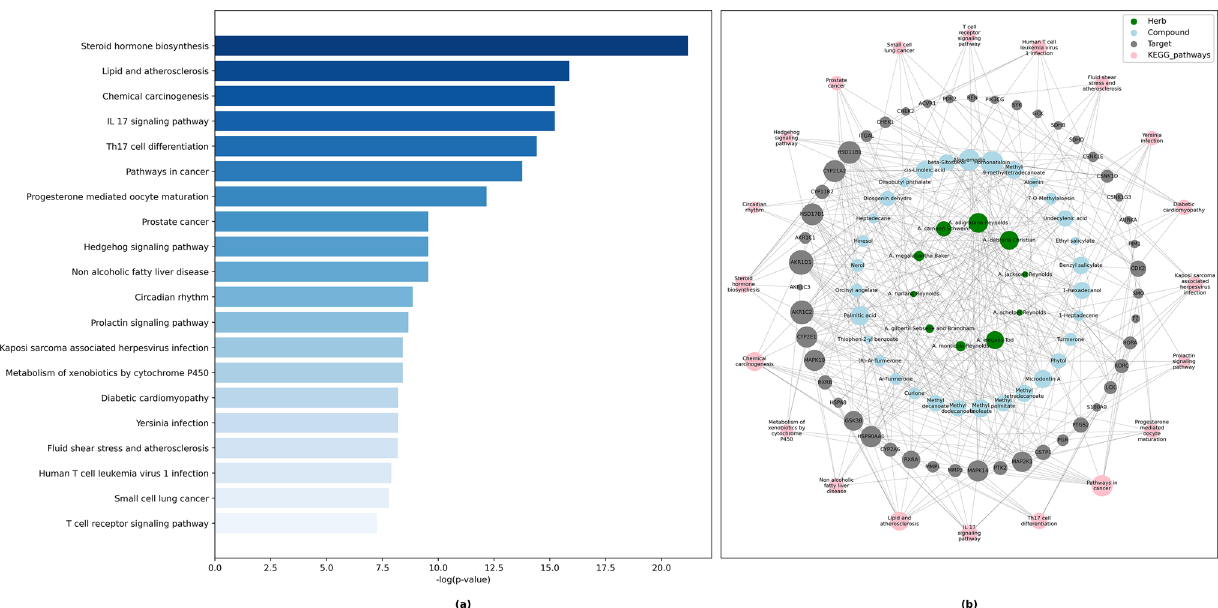
Figure 1. ( a ) Bar graph of KEGG analysis for top 20 enriched pathways. ( b ) Phytochemical-target-pathway network constructed by python NetworkX library illustrated pathways and their associated genes (Adjusted P-value ≤